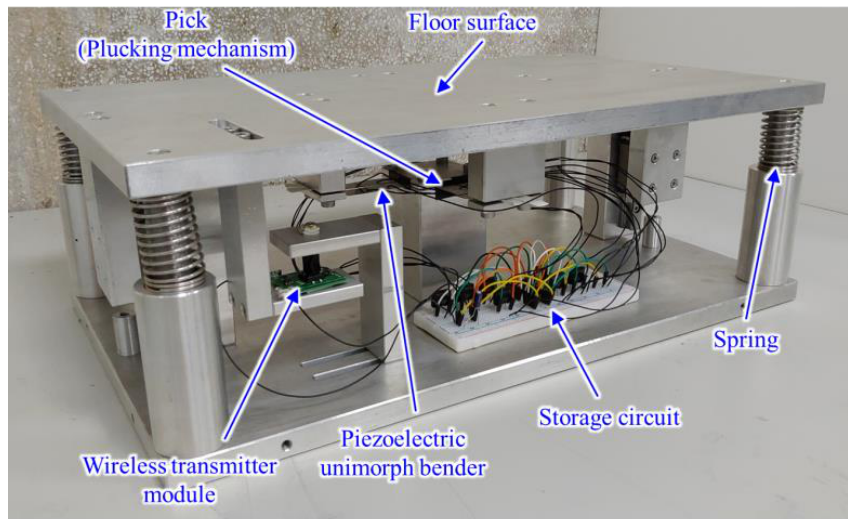
Figure 11. Structure of designed piezoelectric harvesting floor, which consists of a piezoelectric unimorph plate, a plucking mechanism, a storage circuit, and the driven wireless transmitter module.